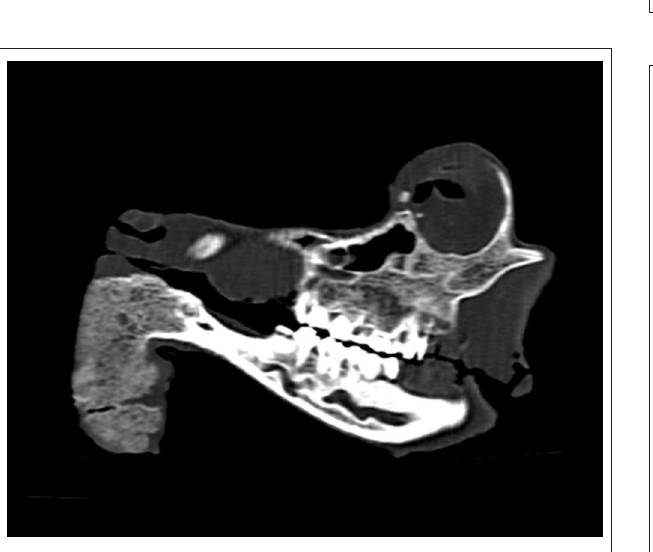
FIGURE 6 | Mandibular mass, roe deer; the bony spicules increase in size from the periphery to the center of the mass; H&E stain. the pharynx ( Figure 9 ). The tumor masses were shiny and light tan on cut